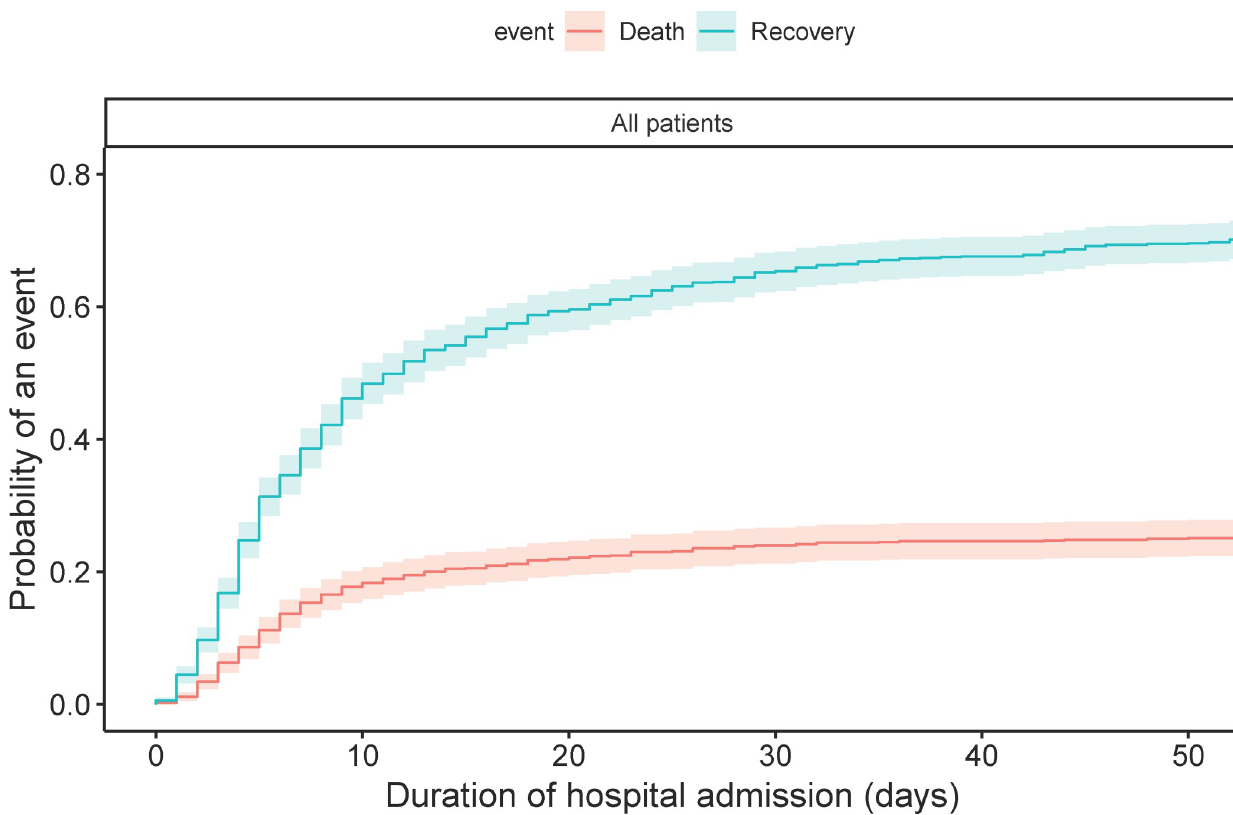
Fig 1. Cumulative incidence plot of death and recovery in the total population. The probability of death conditional on not having recovered after one, two and three weeks of hospital admission was 15.4% (95% 13.1–17.6), 20.5% (95% CI 18.0–23.0), and 22.4% (95% CI 19.8–25.0), respectively. The probability of recovery conditional on not having died after one, two and three weeks of hospital admission was 38.6% (95% CI 35.5–41.6), 54.1% (95% CI 51.0–57.2), and 60.3% (95% CI 57.3–63.3).